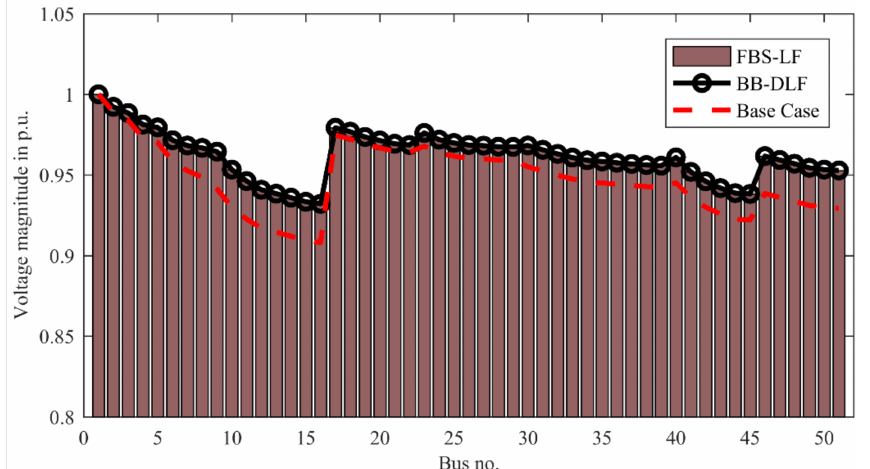
Figure 10. Comparison of voltage profile of PDN as obtained by FBS-LF and BB-DLF when a 1000 kVAr D-STATCOM is allocated to bus 9 of 51-bus